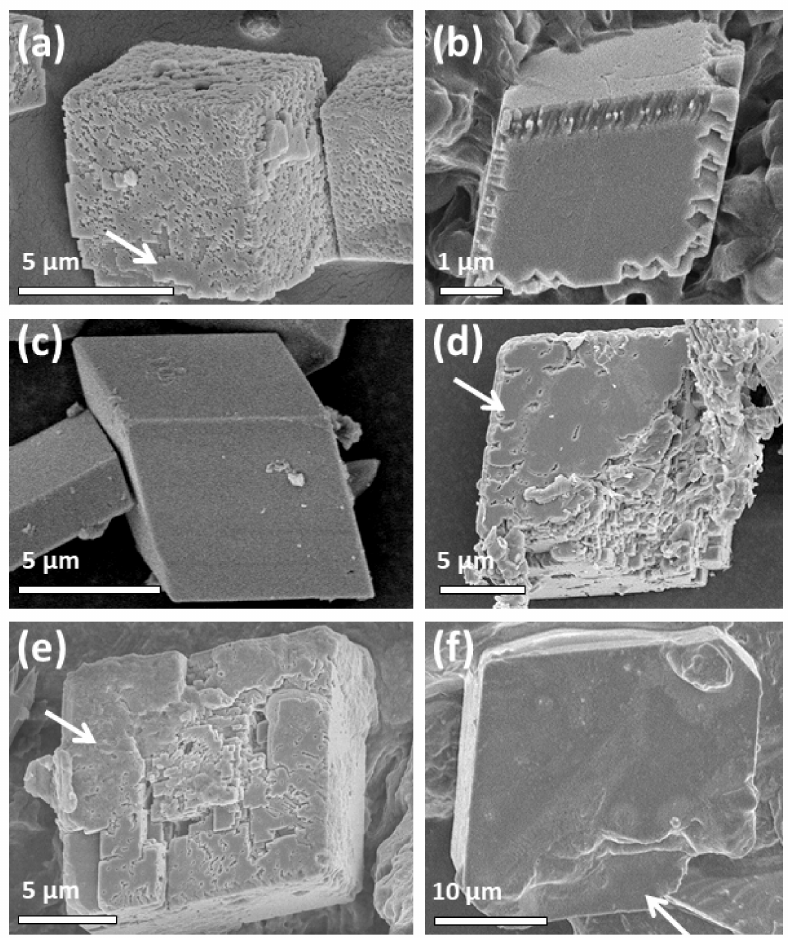
Figure 6. SEM images of calcite crystals prepared in the presence of chitosan. Different incubation times of ( a ) 2 h, ( b ) 4 h, ( c,d ) 23 h, ( e ) 3 days and ( f ) 9 days were applied. The particles in ( d – f ) were pre-crushed in order to reveal their inner structures. The arrow in ( a ) indicates a large single crystal region on the surface of the rhombohedral particle. The arrows in ( d ) and ( e ) point at the single crystal shell whilst the arrow in ( f ) indicates a single crystal core. Reproduced from [45] with permission from The Royal Society of